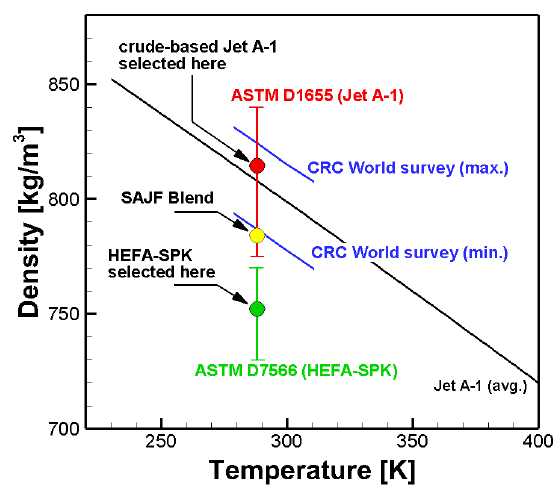
Figure 12. Density of blending components (Jet A-1 and HEFA-SPK) and final SAJF blend with respective specification requirements. Density as function of temperature for average Jet A-1 and field data from [43].